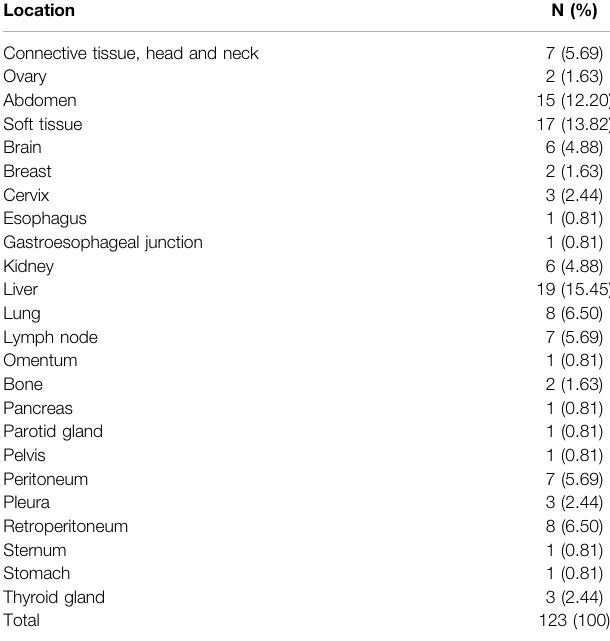
TABLE 3 | Location of excluded core needle biopsies. Location